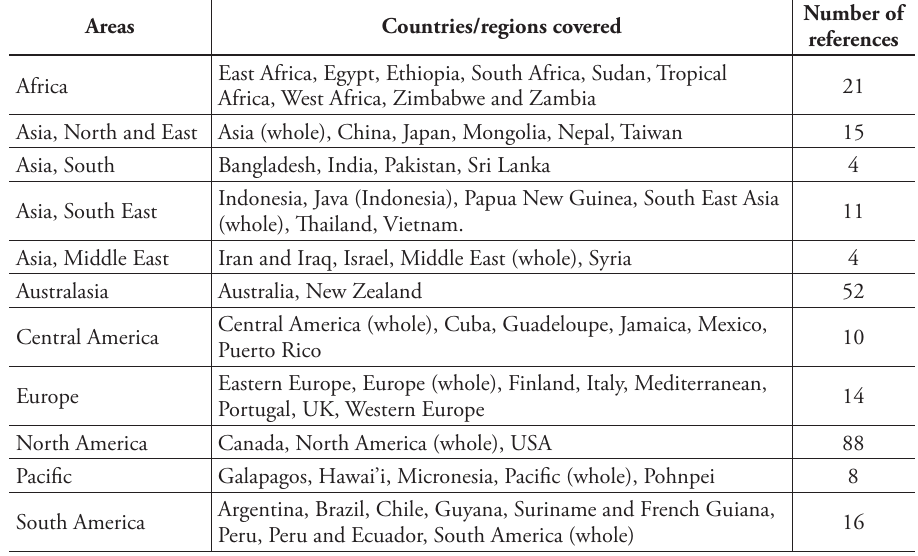
table s1. Description of GCW areas used as as measure of invasiveness, based on references in the Global Compendium of Weeds recording a species in a particular global area. The number of references in the Global Compendium of Weeds referring to each global area is listed, along with the countries (or regions)